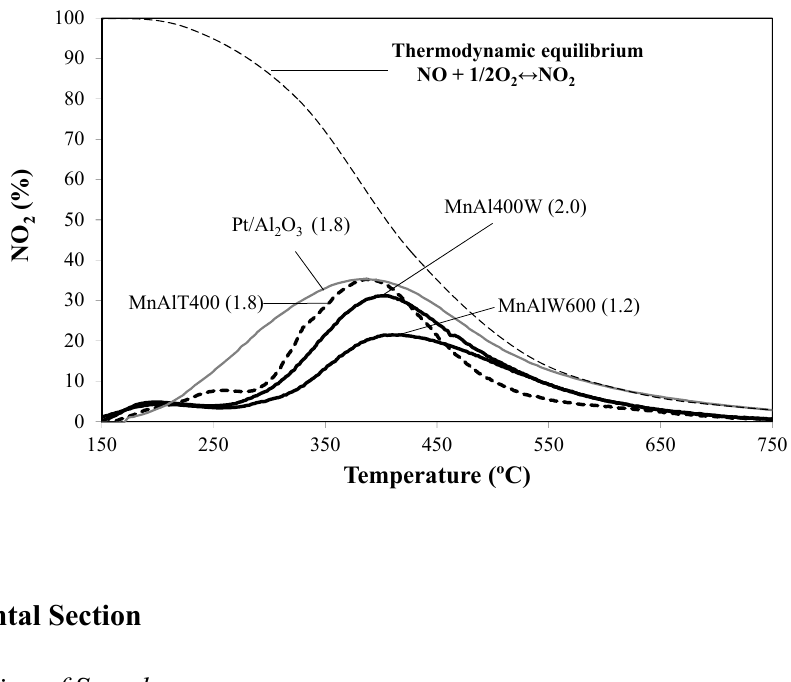
Figure 12. NO percentage in blank experiments (without soot) performed in NO 2 amounts of NO evolved are reported between parentheses in 2